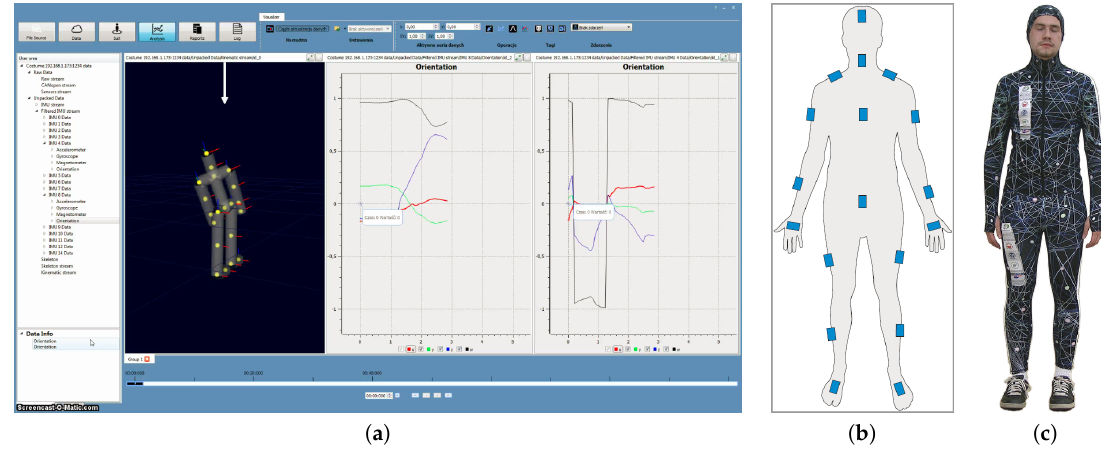
Figure 2. System components: ( a ) MDE software screen-shot; ( b ) sensor locations; ( c ) whole